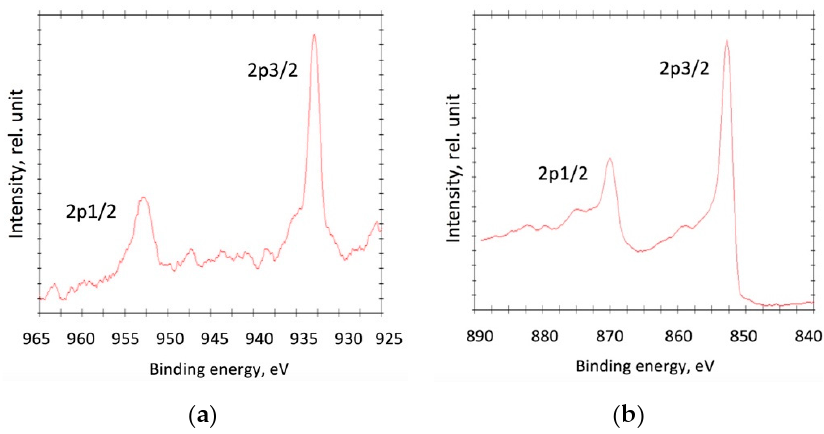
Figure 4. The XRD patterns of the Ti–Al–Cu–N ( a ) and Ti–Al–Ni–N ( b ) coatings.